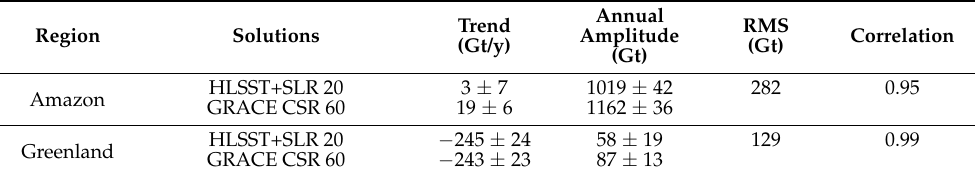
Figure 9. Time series of mass variations over the Amazon Basin ( a ) and Greenland ( b ) derived from GRACE CSR and HLSST+SLR solutions, with coefficients truncated to degree 20 and GRACE CSR nominal degree 60, respectively. Gaussian filtering with a radius of 500 km and 1000 km were applied to GRACE CSR and HLSST+SLR, respectively. The forward modeling (FM) method was used to reduce signal leakage and restore signal strength. The mass variations are values in gigatons. Monthly uncertainties of the recovered mass variations are also shown in the figure. The period covers January 2003 to August 2016. Table 2. Trend and annual amplitude of mass flux over the Amazon and Greenland from HLSST+SLR and GRACE CSR solutions, with coefficients truncated to degree 20 and GRACE CSR nominal degree 60, respectively. Gaussian filtering with a radius of 500 km and 1000 km were applied to GRACE CSR and HLSST+SLR, respectively. The RMS of the difference between HLSST+SLR and GRACE CSR and the correlations with GRACE CSR were also